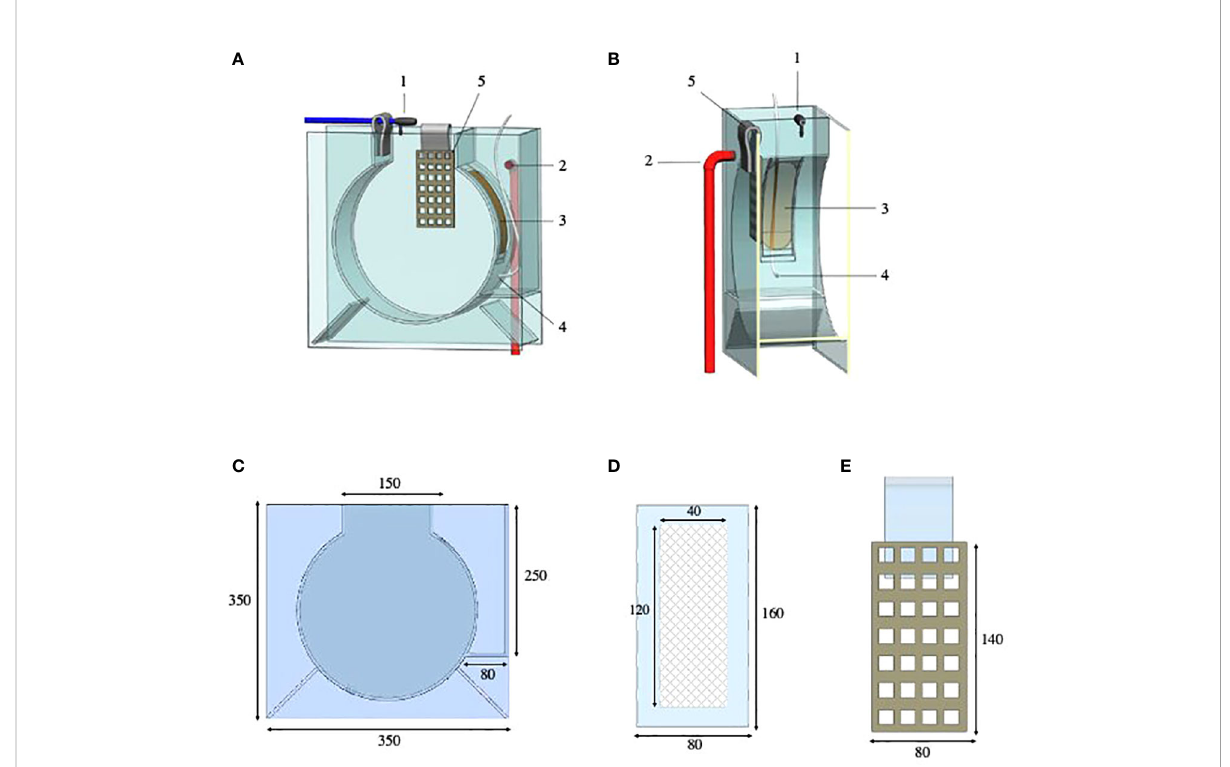
FIGURE 1 Schematic representation of the aquarium and accessories for the growth of the early stages of jelly fi sh: (A) Frontal view. (B) Transverse modi fi ed section. (C) Aquarium measures (mm). (D) Interchangeable mesh screen measures (mm). (E) Polyp plate measures (mm). Aquarium con fi guration: 1, water inlet in the main chamber (blue pipe, Ø ext.=8 mm); 2, water outlet in the drainage chamber (red pipe, Ø ext.=20 mm); 3, interchangeable mesh screen (150, 250, 350 and 500 µm and 1 mm); 4, air inlet in the main chamber (white tube, Ø ext.=5 mm; 5, polyp plate (square grid, 20x20 mm). Polyp plate dimensions can be varied as desired. Schematic representation by Carlos